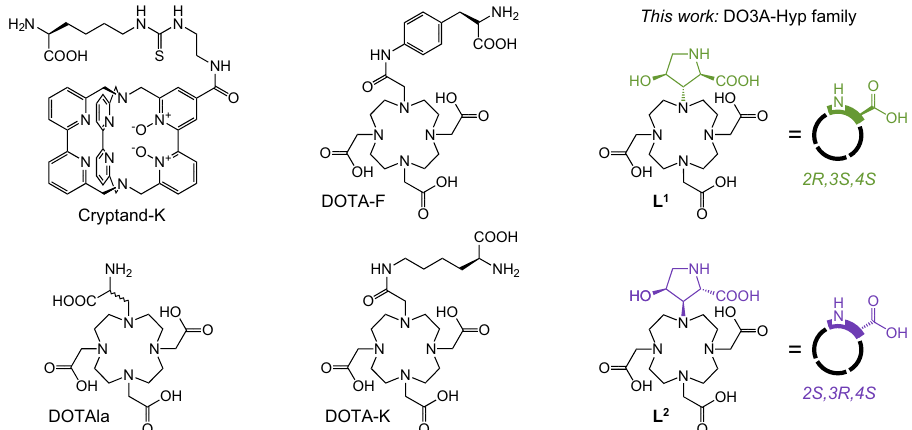
Fig. 2 Chemical structures of amino acid/chelator building blocks for incorporation of Ln 3 + ions into peptides discussed in this work. Structures were redrawn without protective groups and metal ions from references: Cryptand-K 24 , DOTA-K 49,50 , DOTA-F 50 , and DOTAla 51 . The DO3A-Hyp family of building blocks presented in this work comprises two isomers that differ in the con fi guration of chiral centers in the Hyp (hydroxyproline) moiety: isomer 2R , 3S , 4S ( L 1 , green shading) and isomer 2S , 3R , 4S ( L 2 , violet